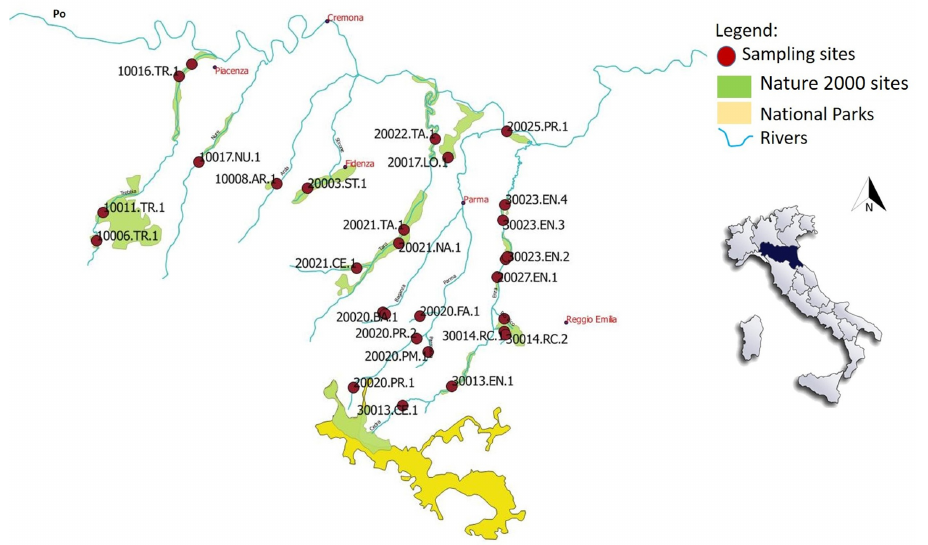
Figure 1. Map describing the locations of sampling sites. Sampling sites along the main Po river tributaries were identified by specific codes attributed in the framework of the Nature 2000 Network.